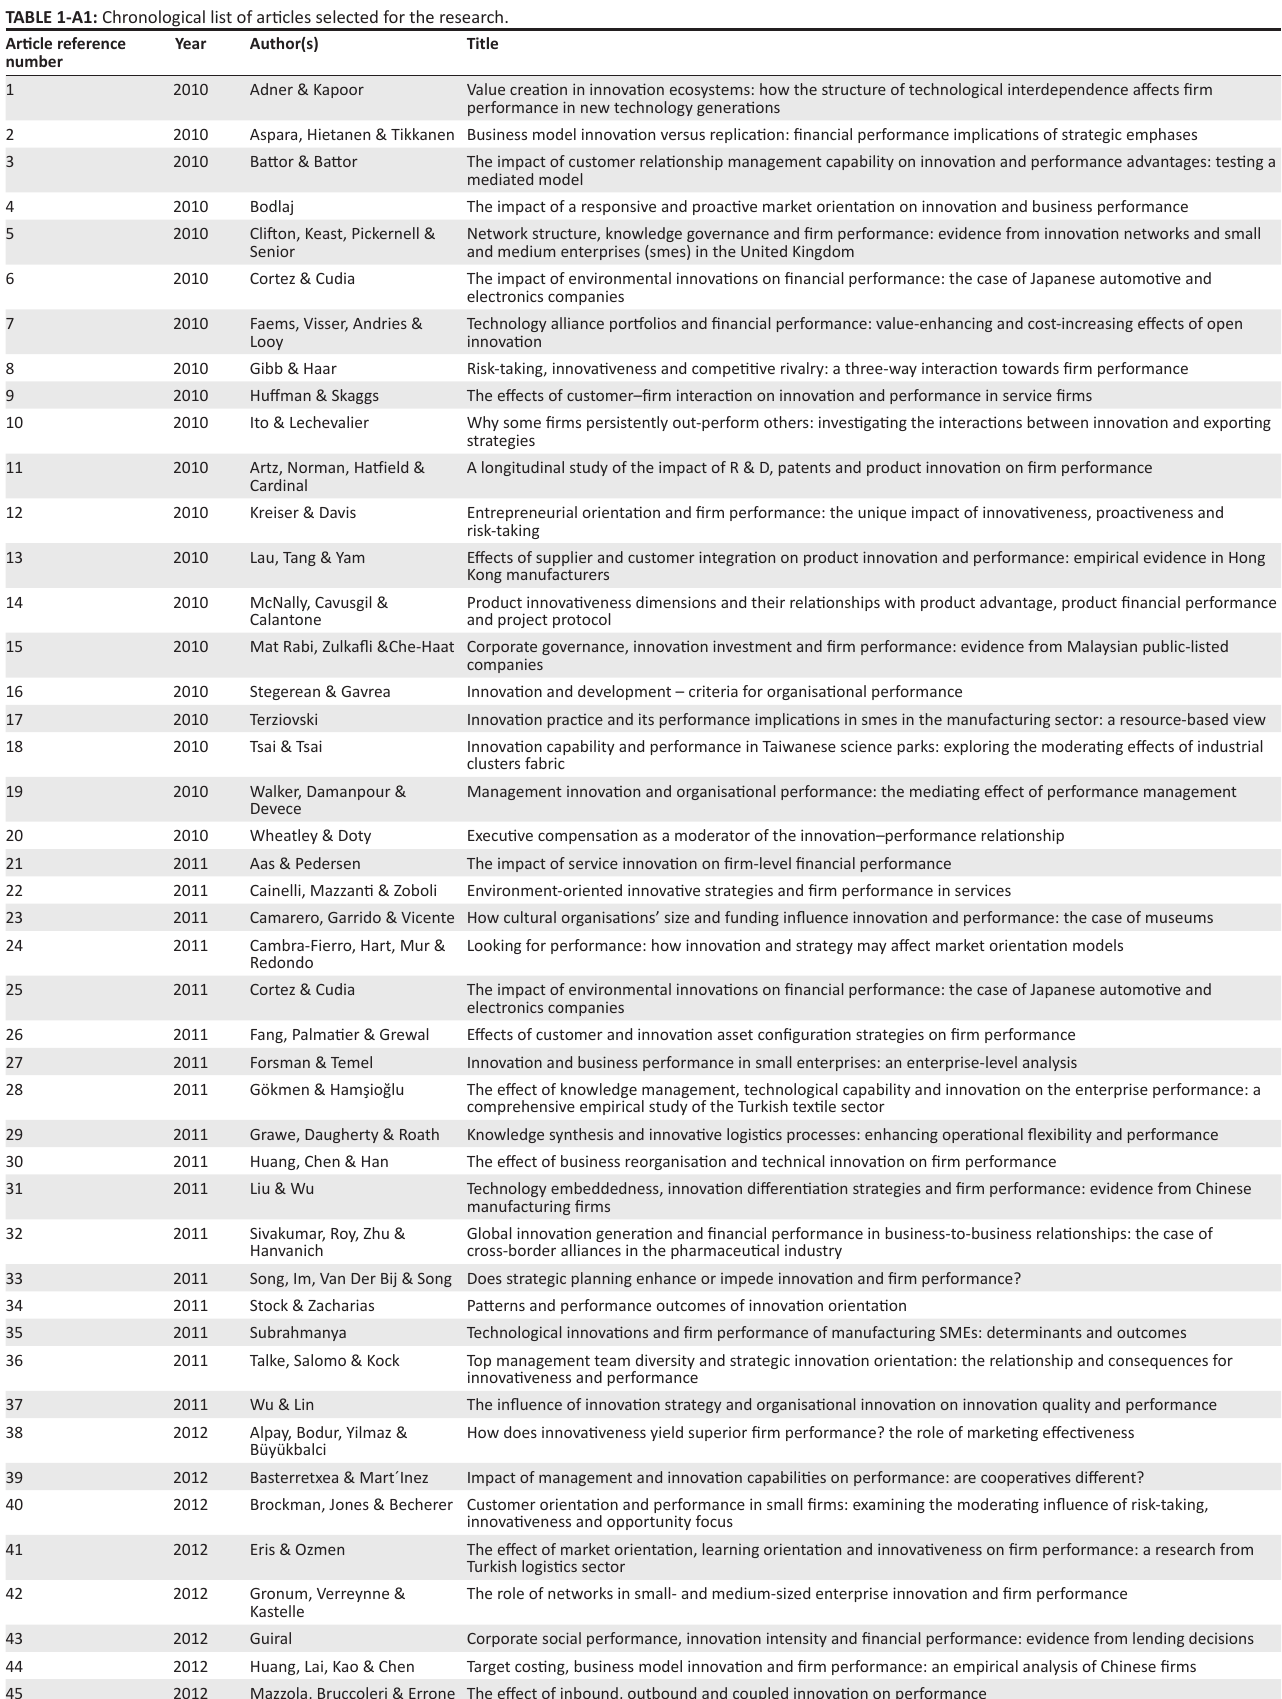
TABLE 1-A1: Chronological list of articles selected for the